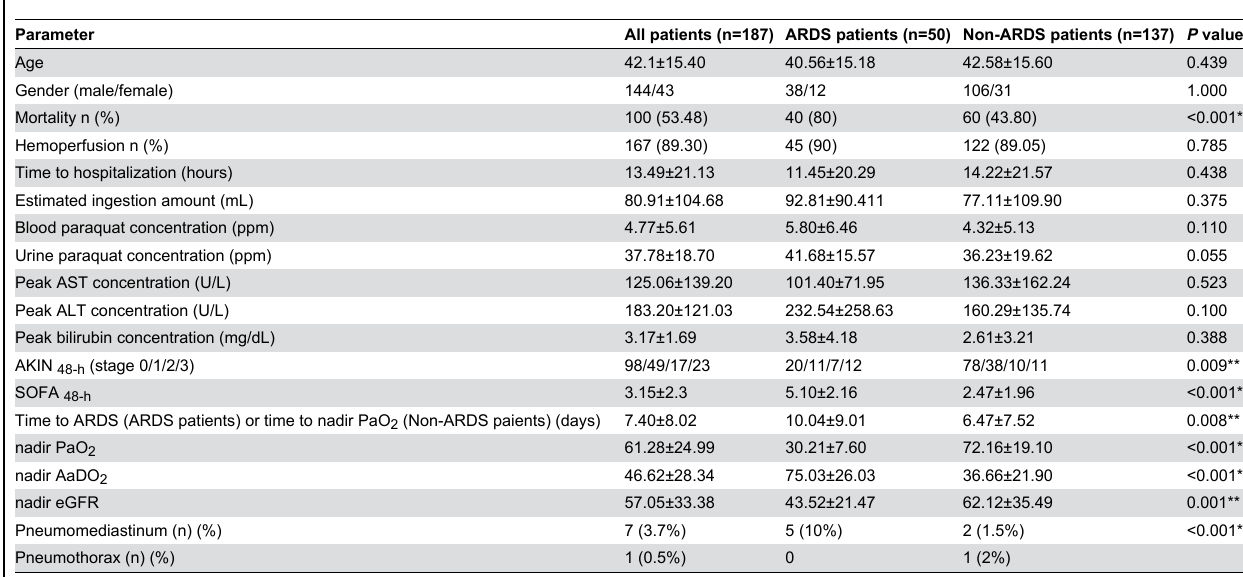
Table 3. Baseline demographics and clinical characteristics of paraquat patients with and without ARDS (n=187).